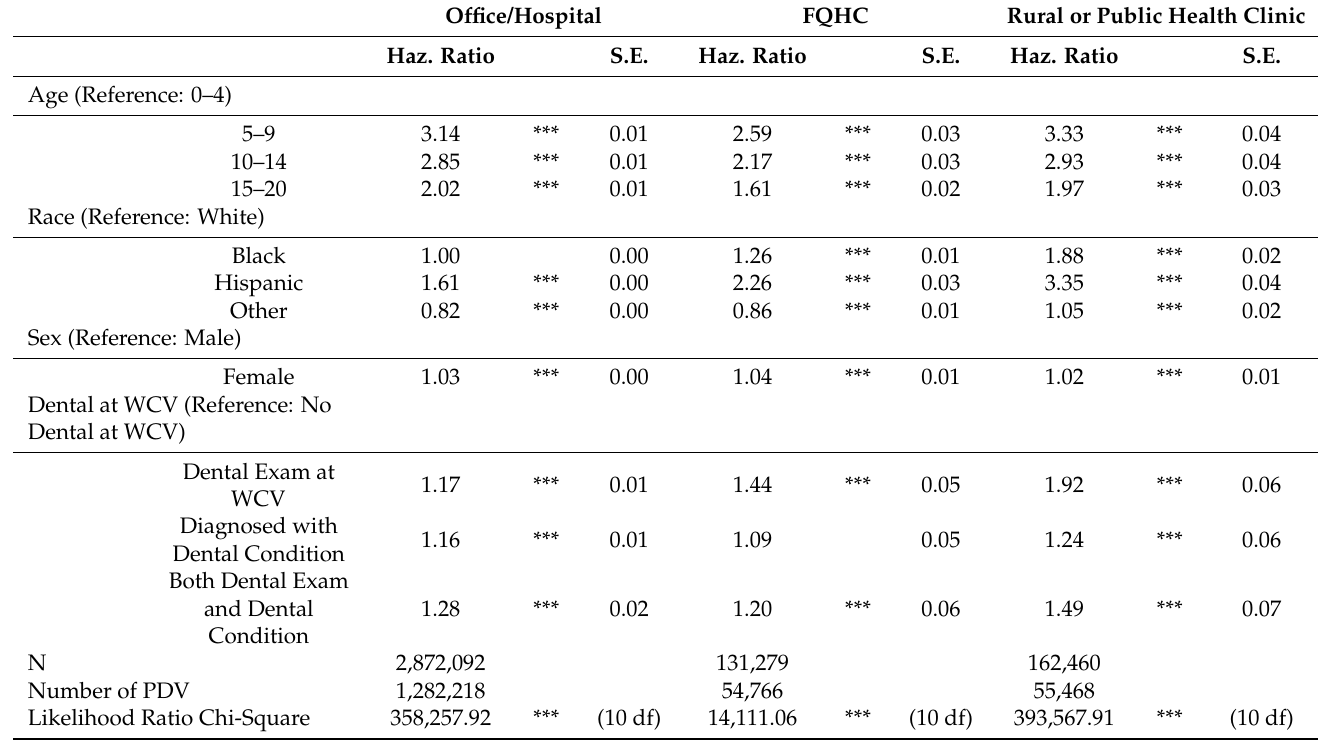
Table 2. Rate of Preventive Dental Visit (PDV) for children who received a Well-Child Visit (WCV) based on location, by age, race, gender and dental